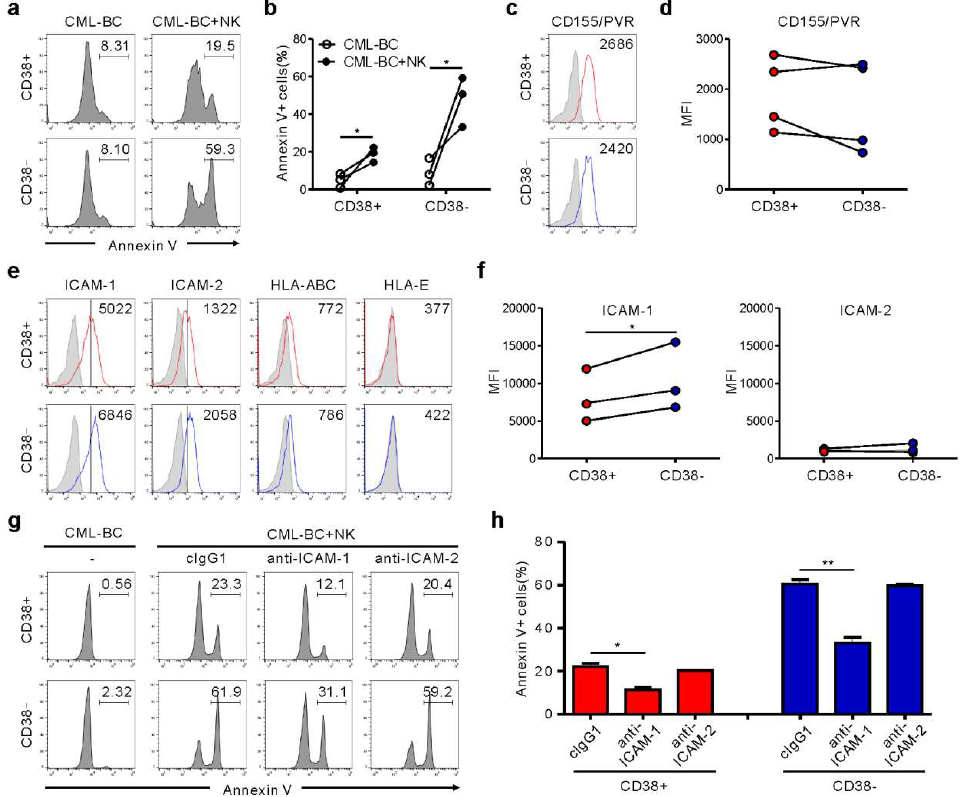
Figure 4. NK cells trigger preferential cytolysis of the CD34 + CD38 − subset in CML-BC blasts through an interaction with ICAM-1. ( a , b ) Apoptosis of CD38 + vs. CD38 − subsets on gated CD34 + CML-BC cells ( n = 3) in the absence or presence of NK cells, as measured by annexin V-FITC, anti-CD34-PE, and anti-CD38-APC staining. Shown are representative flow cytometry profiles ( a ) and a matched line graph ( b ) demonstrating the percentage of apoptotic CD34 + CD38 − vs. CD34 + CD38 − cells. ( c , d ) Similar surface levels of CD155 / PVR between CD38 + and CD38 − subsets on gated CD34 + CML-BC cells ( n = 4). Shown are representative flow cytometry profiles ( c ) and a matched line graph ( d ) demonstrating the MFI of PVR expression on CD34 + CD38 − vs. CD34 + CD38 − cells. ( e ) Representative flow cytometric profiles showing the surface expression of adhesion ligand (ICAM-1 and ICAM-2) or inhibitory ligand (HLA-ABC and HLA-E) on CD34 + CD38 + vs. CD34 + CD38 − subsets. The representative mean fluorescence intensity (MFI) of each ligand in the histogram is presented as the result of two independent experiments. ( f ) Upregulated levels of ICAM-1 on the CD34 + CD38 − subset compared with CD34 + CD38 + subsets ( n = 3). Shown are matched line graphs demonstrating the MFI of ICAM-1 and ICAM-2 expression on CD34 + CD38 − vs. CD34 + CD38 − cells. ( g , h ) MNCs from a CML-BC patient were incubated with expanded primary NK cells preincubated with mAb to the indicated receptors (20 µ g / mL) for 2 h. Apoptosis of CD38 + vs. CD38 − subsets on gated CD34 + CML-BC cells was measured as in ( a ). Shown are representative flow cytometry profiles ( g ) and a graph of statistical bar charts ( h ) demonstrating the percentage of apoptotic CD34 + CD38 − vs. CD34 + CD38 − cells. The mean values ± s.d. of two independent experiments are shown. * p < 0.05; ** p < 0.01 by Student’s t